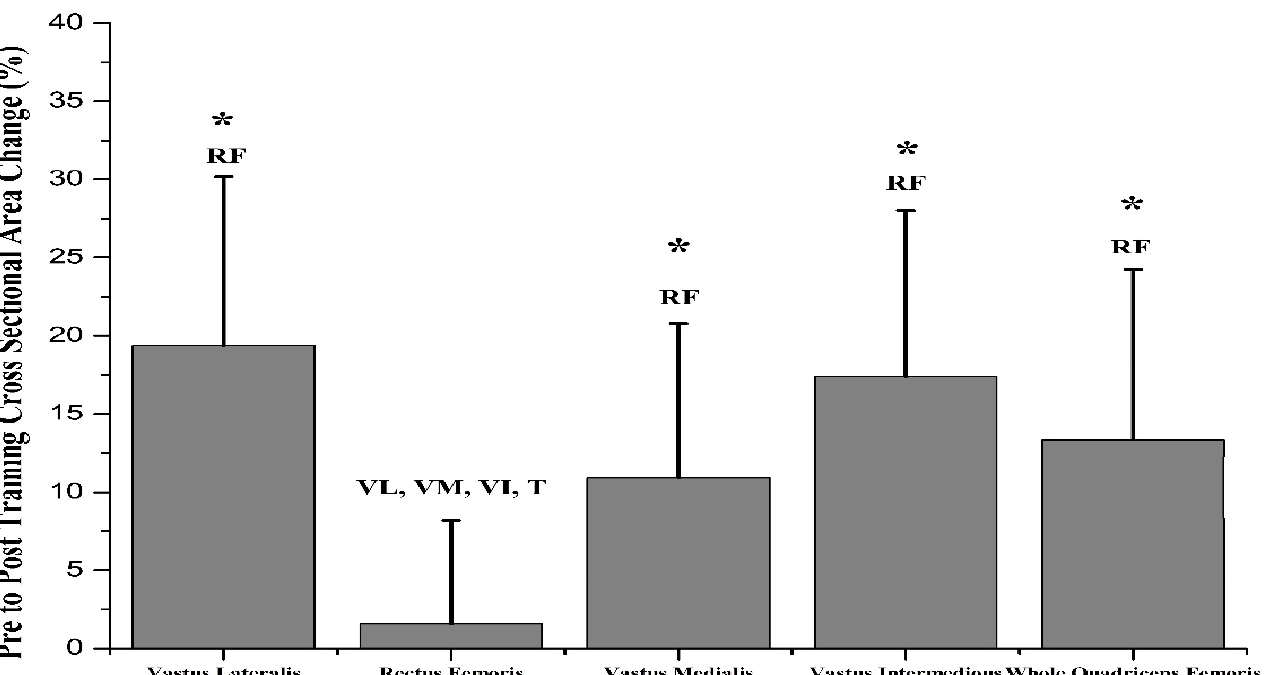
Figure 1. Pre- to post-training percentage changes (%) of Vastus Lateralis, Rectus Femoris, Vastus Medialis, Vastus Intermedious and Total Quadriceps Femoris cross-sectional areas. With (*) denoted the significant differences between pre and post-training cross-sectional areas absolute values for each muscle separately as well as for the Total Quadriceps Femoris ( p < 0.05). Small letters de- note statistically significant differences between the marked groups (where VL = Vastus Lateralis, RF = Rectus Femoris, VM = Vastus Medialis, VI = Vastus Intermedious, T = Total Quadriceps